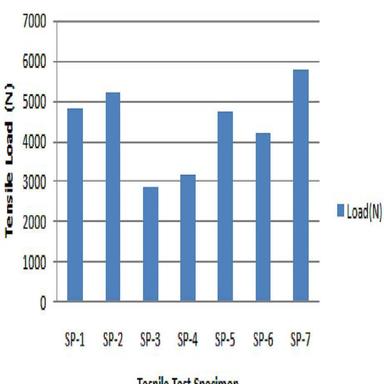
Tensile load obtained by specimens.